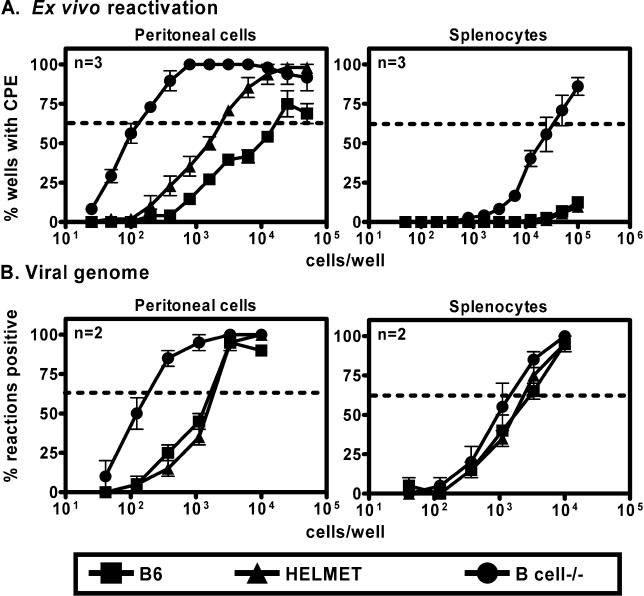
Virus Non-Specific B Cells Control Latent Infection(A) Ex vivo reactivation from latency in peritoneal cells (left) and splenocytes (right) from B6, HELMET, and B cell−/− mice 42 d after infection. Dotted lines indicate the 63.2% Poisson distribution line used to calculate the frequency of cells reactivating virus.(B) Frequency of cells from peritoneal cells (left) and splenocytes (right) carrying γHV68 genome in B6, HELMET, and B cell−/− mice at day 42 post infection. Dotted lines indicate the 63.2% Poisson distribution line used to calculate the frequency of cells carrying viral genome. As indicated in the Materials and Methods section, results from 10–15 total mice from two to three independent experiments ± SEM are reported here.